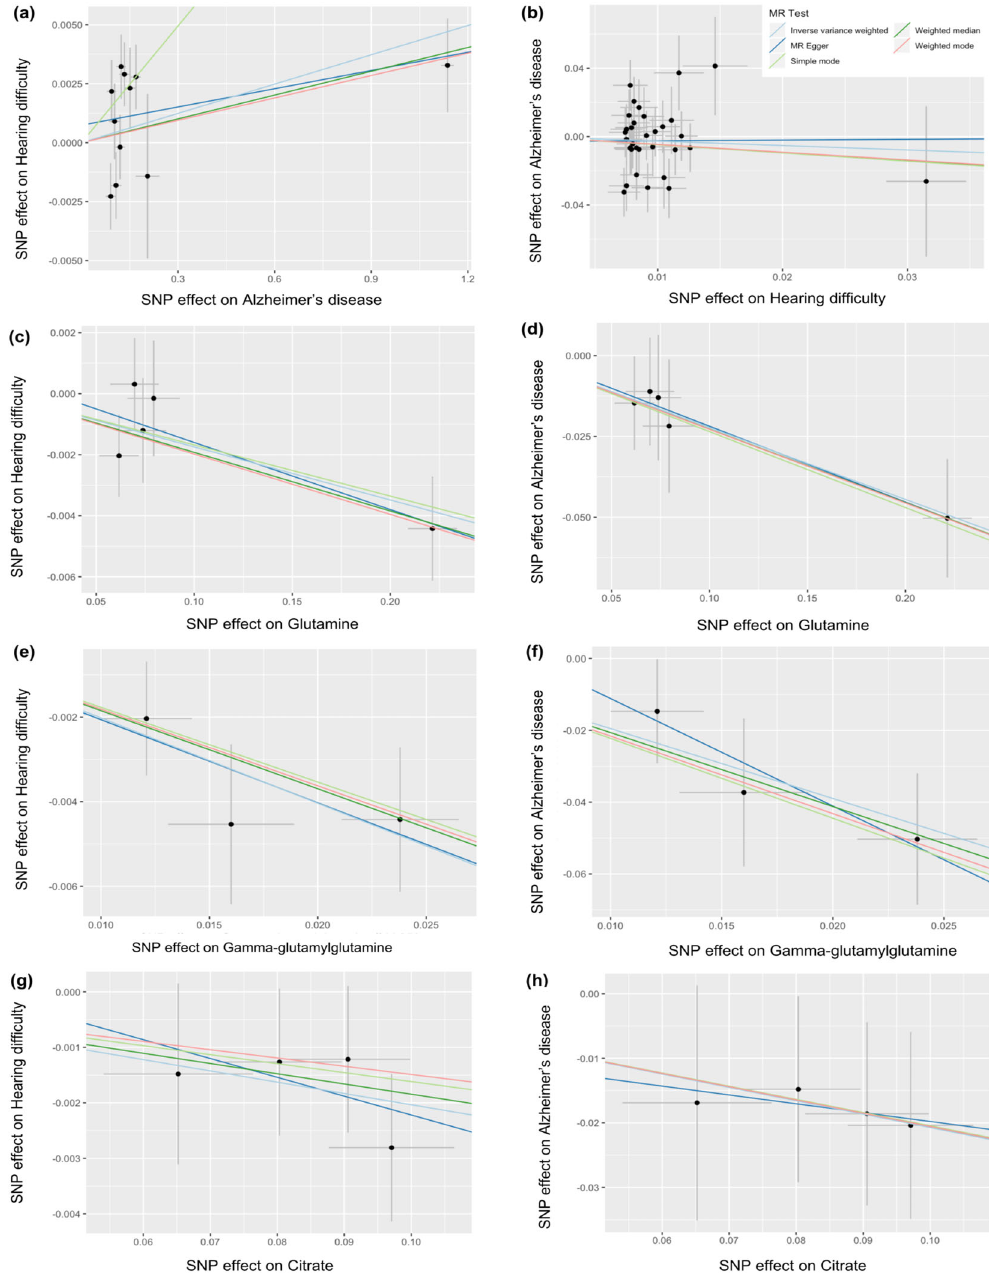
Fig. 3 MR regression plots for instrumental SNPs on x axis and outcome SNPs on y axis. MR regression plots for SNP effect on Hearing dif fi culty plotted against SNP effect on a Alzheimer ’ s disease, c glutamine, e gamma-glutamylglutamine, g citrate and SNP effect